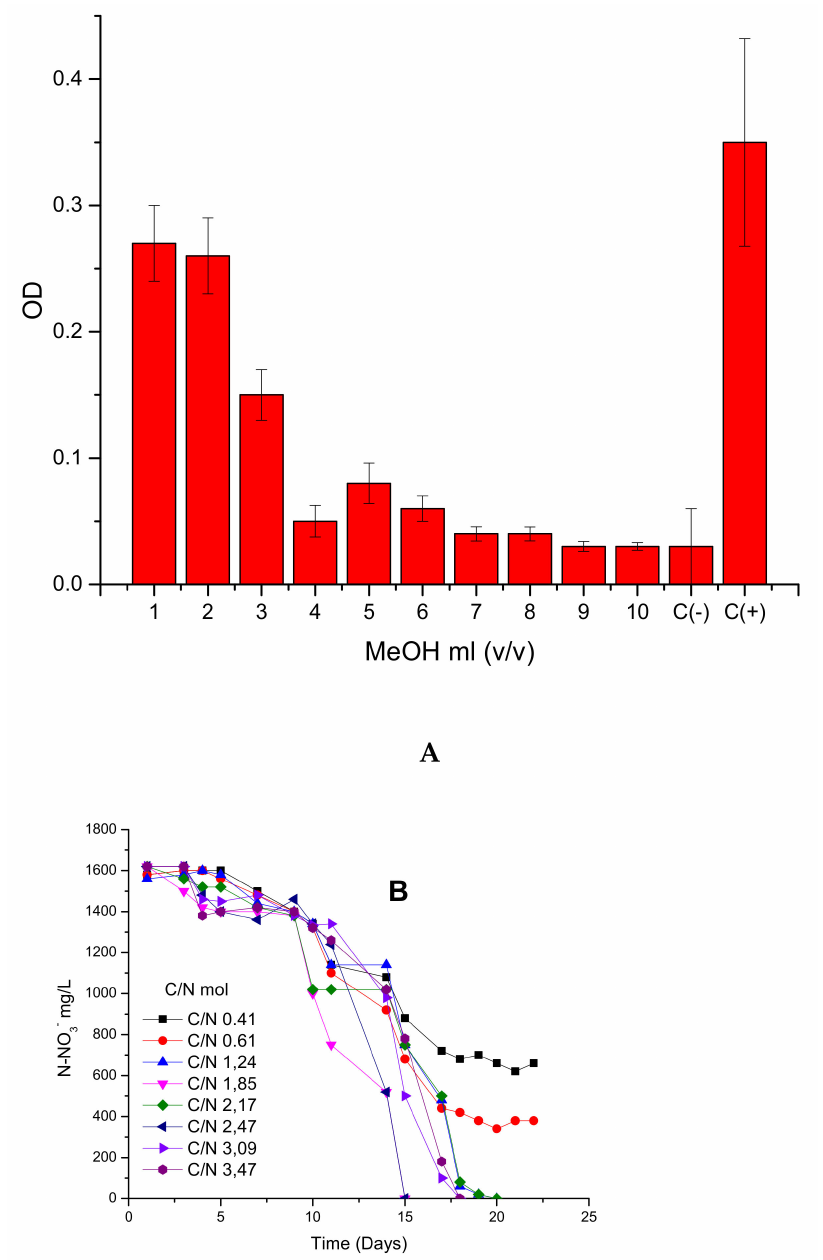
Figure 6. ( A ) Methanol toxicity over bacterial growth measures as optical density (OD) for increasing concentrations (1 a 10%). ( B ) Denitrification for different C/N ratios and limitation on carbon